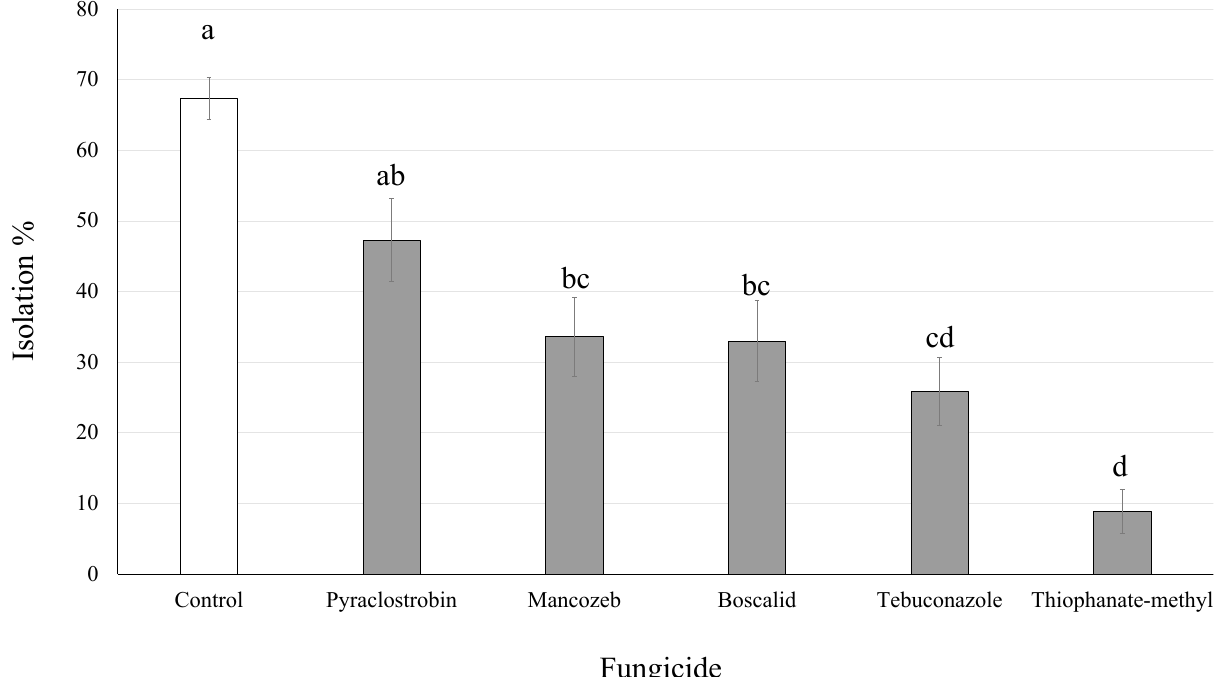
Figure 2. Mean isolation percentages of four Botryosphaeriaceae spp. on pruning wounds of almonds cv. Ferragnes, 5 months after pruning and fungicide application. Mean lesion lengths are based on 48 replicates per fungicide (three repli - cates for each of the four fungi and two inoculation times, and the experiment was conducted twice). Means followed by the same letter are not significantly different ( P > 0.05). Bars represent the standard errors of the